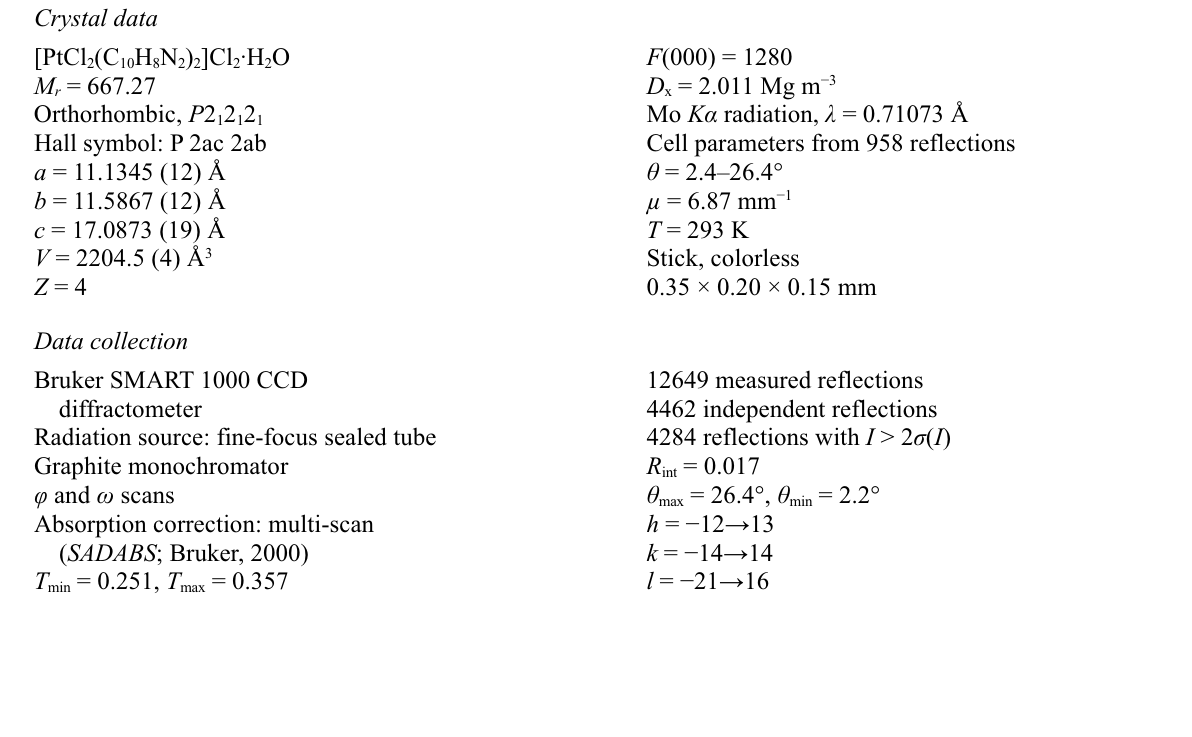
The structure of the title compound, with displacement ellipsoids drawn at the 50% probability level for non-H atoms. Bis(2,2 ′ -bipyridine- κ 2 N , N ′ )dichloridoplatinum(IV) dichloride